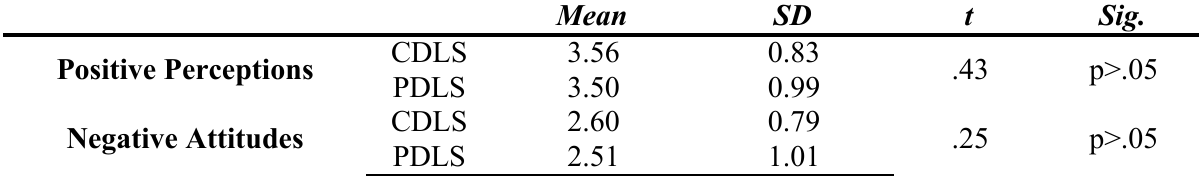
The Overview of Learning Perceptions